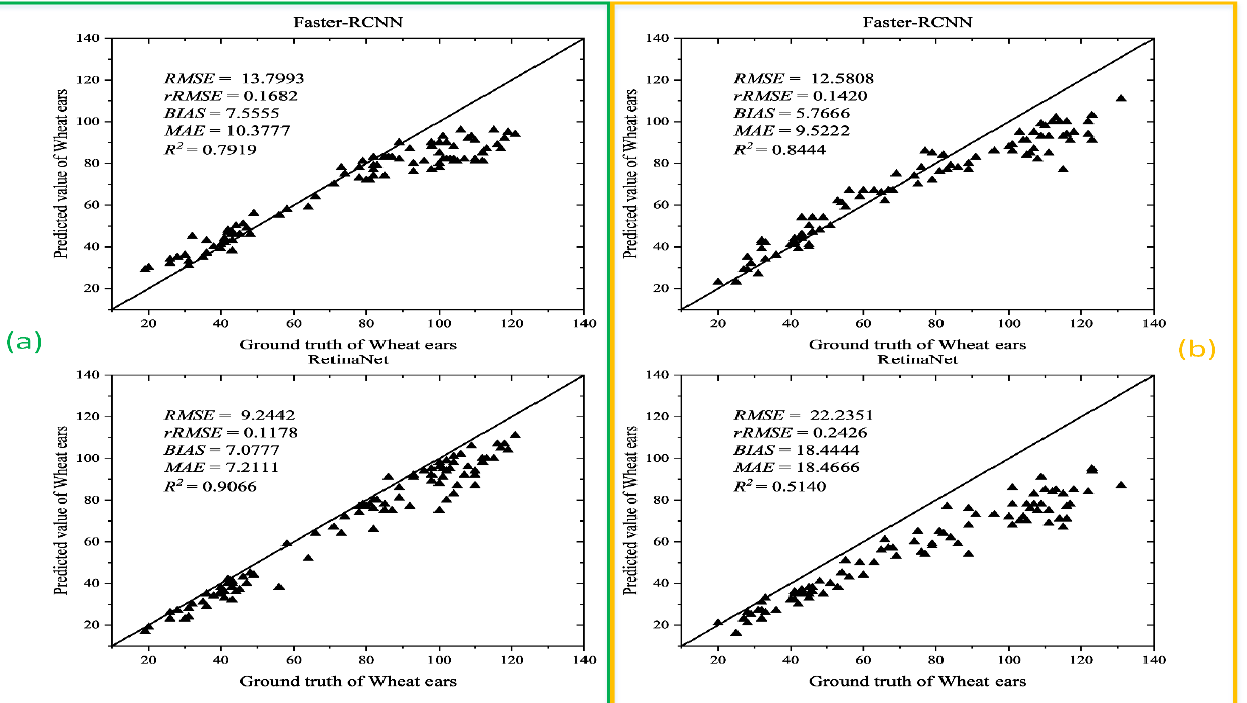
Figure 8. Wheat ear recognition accuracy of Faster R-CNN and RetinaNet models on the test set with images collected in ( a ) in filling stage; ( b ) in mature stage.